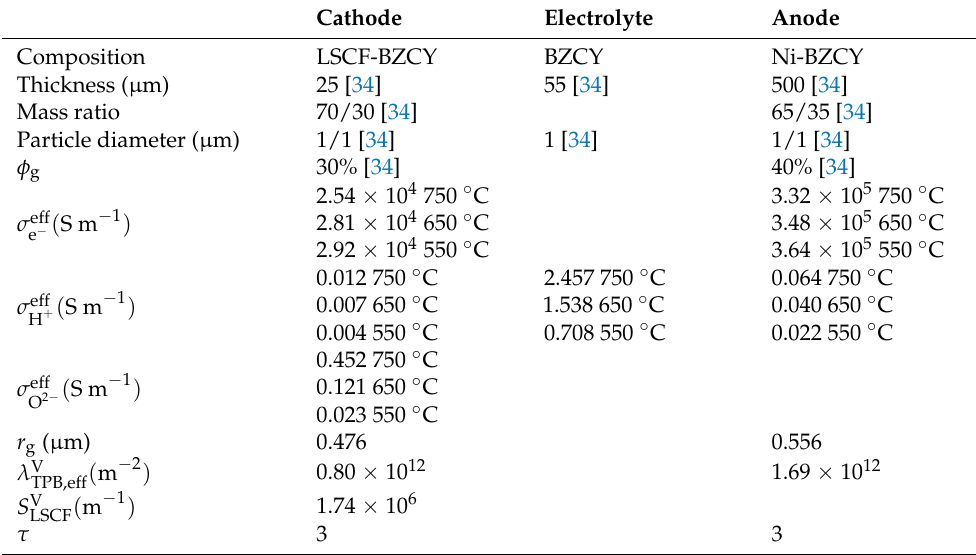
Table 1. Microstructure parameters and the effective properties of each PCFC component. Cathode Electrolyte Anode Composition LSCF-BZCY